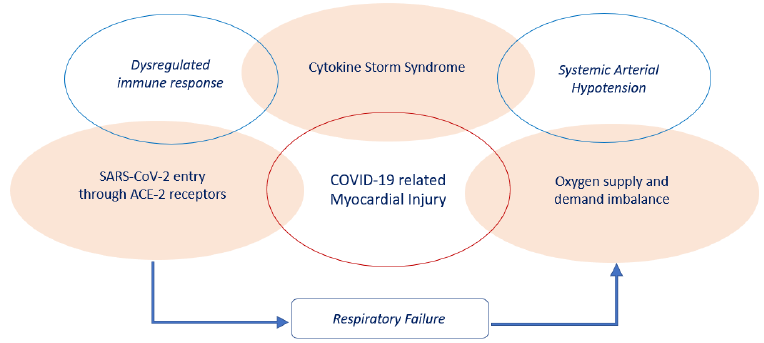
Figure 1. Mechanisms implicated in the pathogenesis of COVID-19 related myocardial injury.